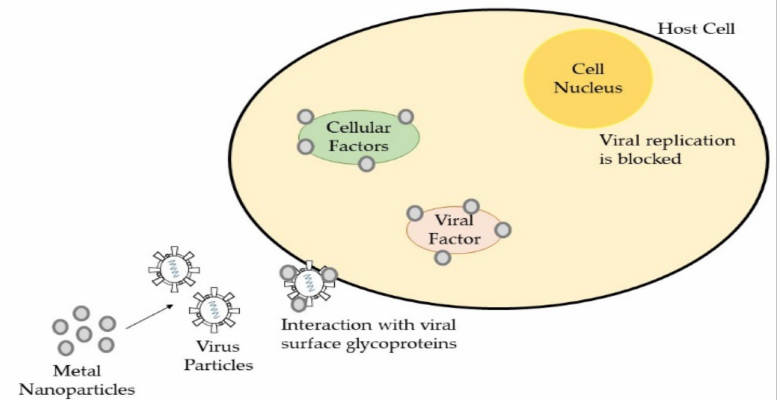
Figure 7. Antiviral mechanism of metal nanoparticles during virus